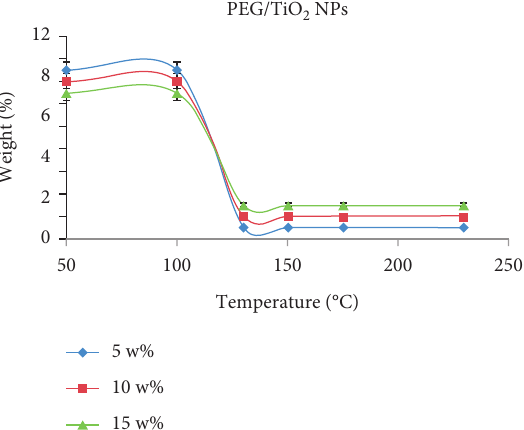
Figure 7: Thermogravimetric analysis of P. cylindraceus oil/PEG/TiO 2 bionanocomposite films containing different concentrations of 5, 10, and 15 w% of PEG/TiO 2 NP. Table 2: Results of hydrolytic degradation of bionanocomposite (90%) film expressed as weight loss (%). Time